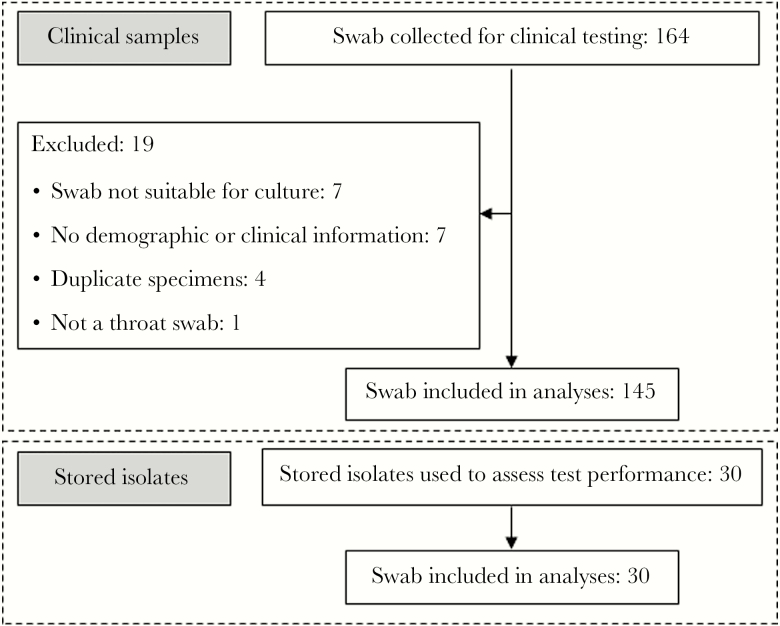
Study flow chart.